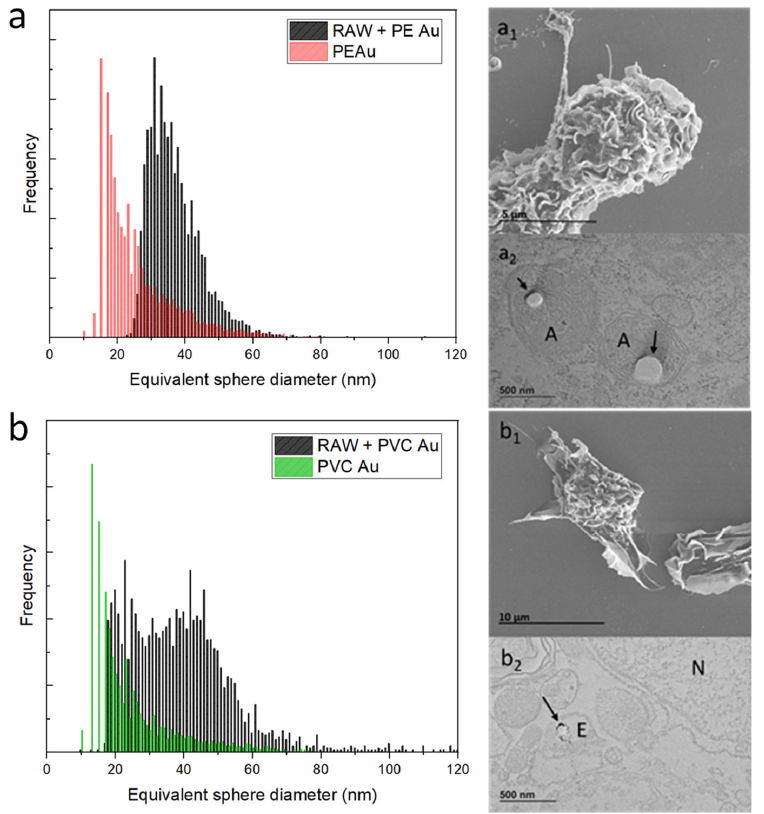
Figure 3. ( a ) Equivalent sphere diameter distribution of PE Au (red) and RAW 264.7 cells, incubated with PE Au for 48 h (black) at a concentration of 1 μ g mL − 1 . ( a 1 ) The SEM image of the RAW 264.7 cells incubated with PE Au for 48 h does not show the presence of any nanoplastics interacting with the cell membrane or as background materials. ( a 2 ) TEM image of slices of RAW 264.7 cells after 48 h of incubation with PE Au, displaying the presence of PE Au (arrows) inside amphisomes (A), confirming the internalization. ( b ) Equivalent sphere diameter distribution of PVC Au (green) and RAW 264.7 cells incubated with PVC Au for 48 h (black) at a concentration of 1 μ g mL − 1 . ( b 1 ) The SEM image of the RAW 264.7 cells, incubated with PVC Au for 48 h, does not show the presence of any nanoplastics interacting with the cell membrane or as background materials. ( b 2 ) The TEM analysis of the sample reveals the presence of nanoplastics (indicated by arrows) internalized inside the endosome (E); the nucleus is marked N.